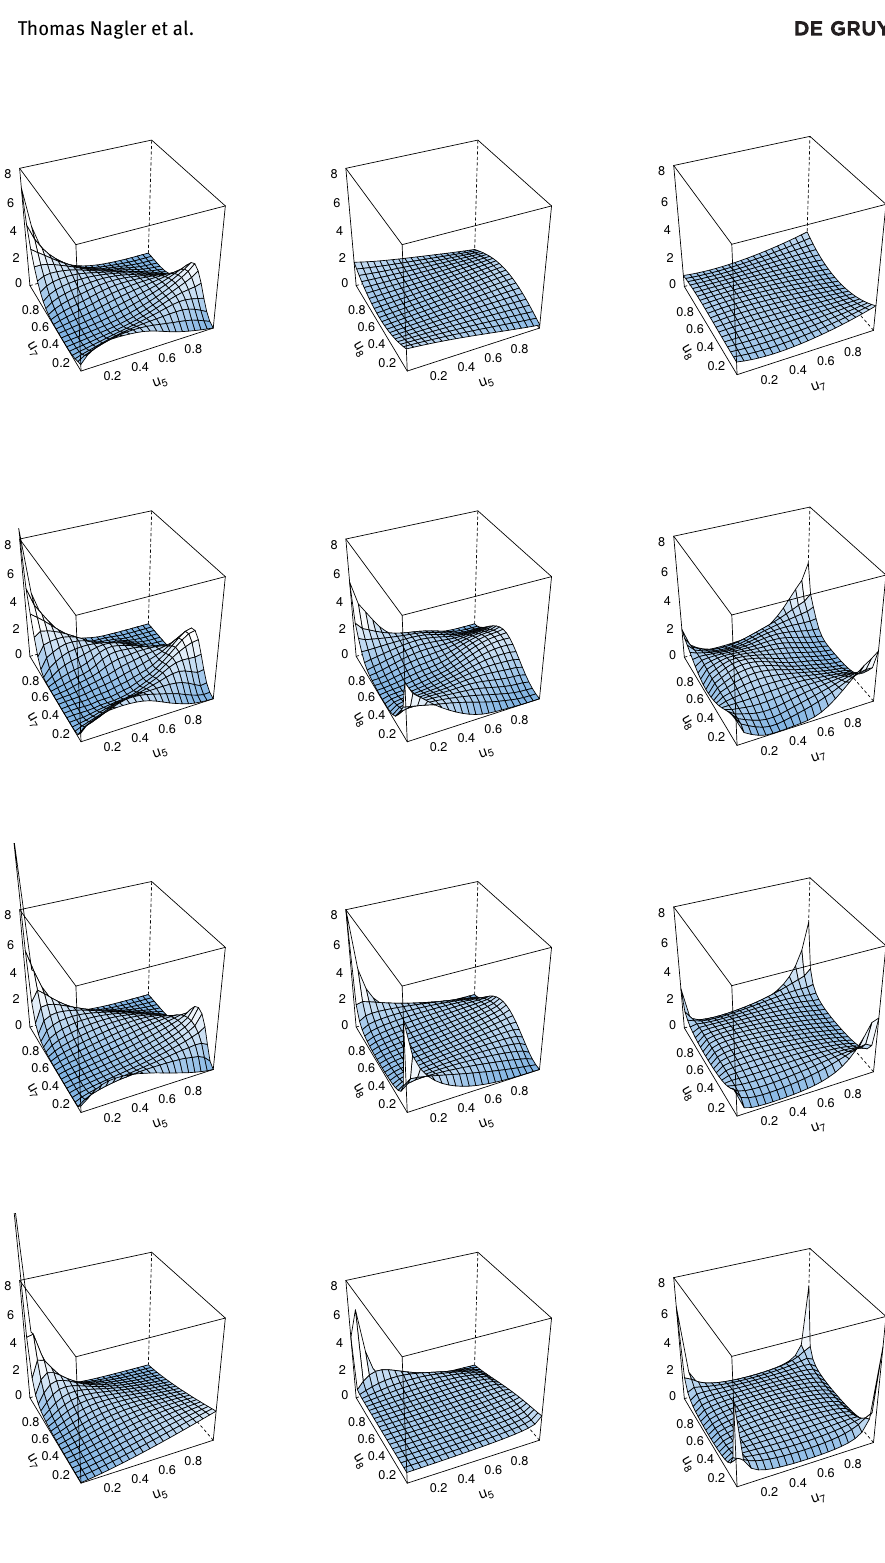
Figure 6: Exemplary density plots for MAGIC data ( n = 2000 ). 1st row: Bernstein estimator bern , 2nd row: penalized quadratic B-splines estimator pspl2 , 3rd row: kernel estimator tll2 , 4th row: parametric estimator par